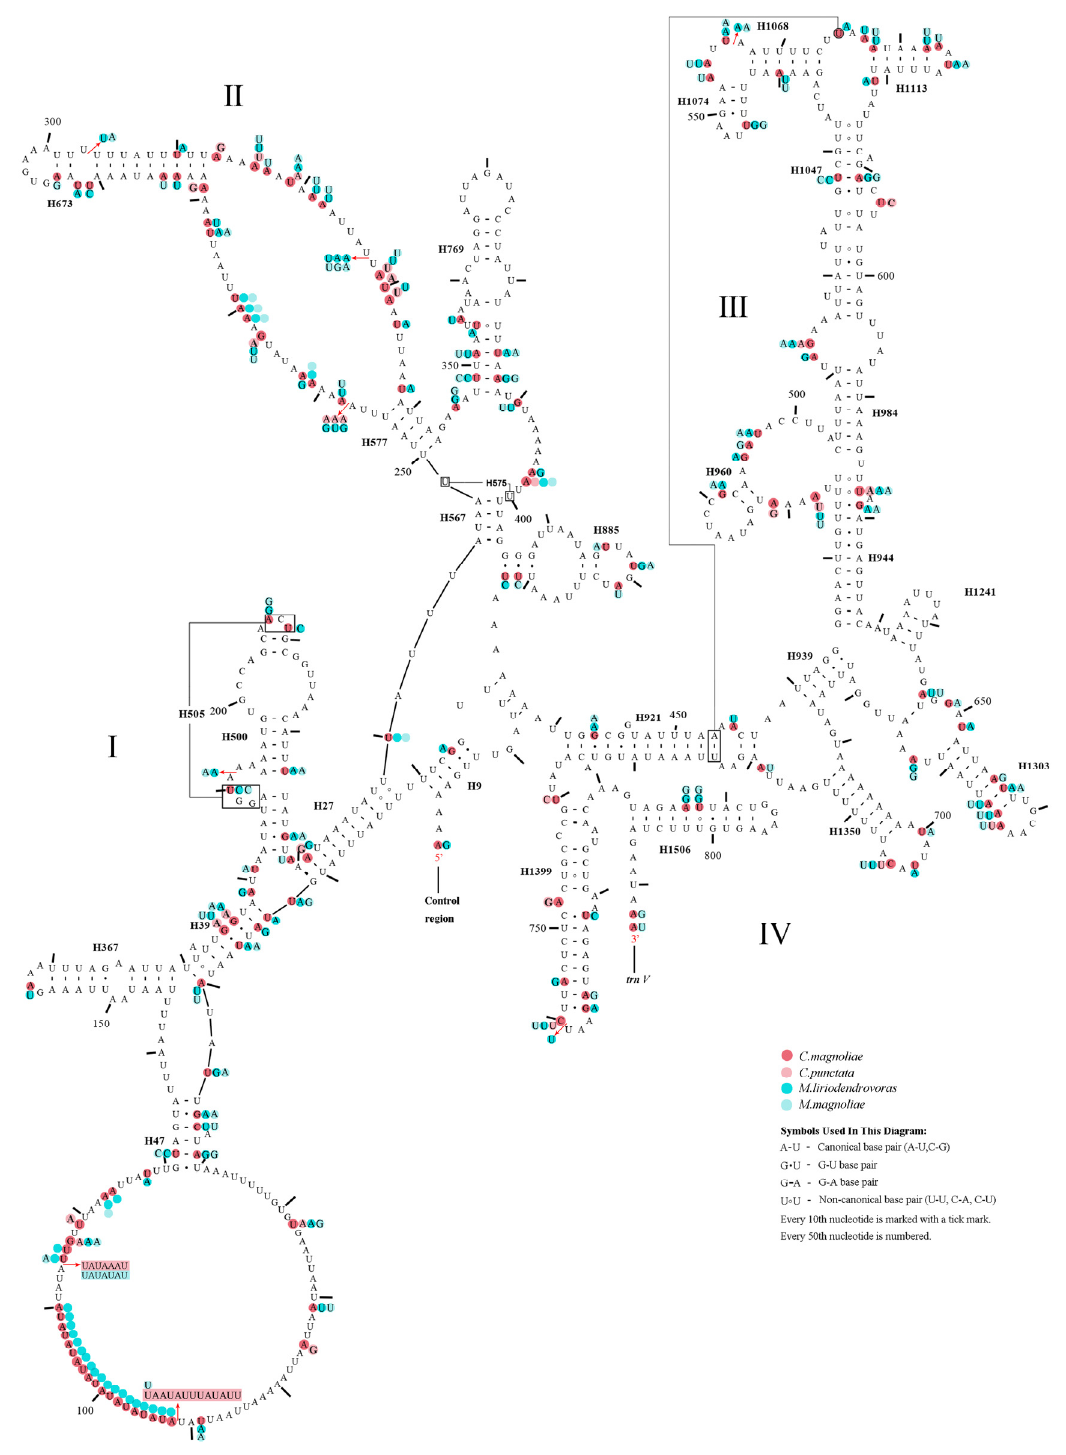
Figure 4. Predicted rrnS secondary structure in the Cladiucha mitochondrial genome. The numbering of helices follows Gillespie et al. [52]. Roman numerals refer to domain names. Tertiary inter-actions and base triples are connected by continuous lines. C. magnoliae as a basemap and base change among Cladiucha species are presented in circles with red ( C. magnoliae ) and pink ( C. punctata )